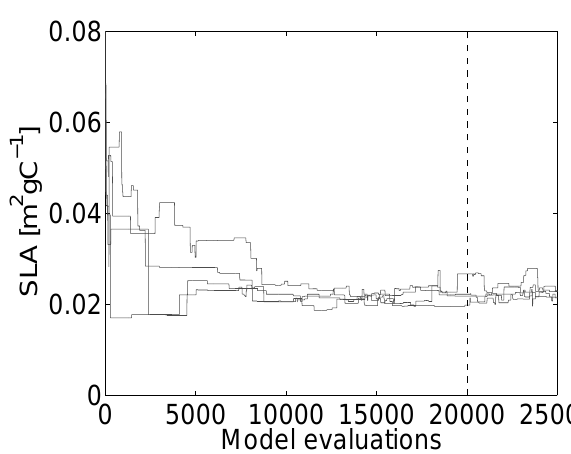
Figure 1. Sampled values of the specific leaf area (SLA) by DREAM ( ZS ) parametrized with four chains for the Oensingen site and the fixed homoscedastic error model (inversion HO1). The ver- tical dashed line indicates when convergence has been reached ac- cording to the ˆ R